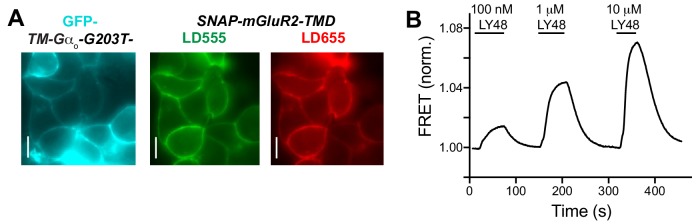
Further analysis of G protein effects on inter-TMD rearrangement.(A) Representative images of HEK 293T cells expression GFP-TM-GαoA-G203T (blue) and SNAP-mGluR2-TMD labeled with donor (green) and acceptor (red). Scale bars = 20 µm. (B) Representative inter-TMD FRET trace showing dose-dependent LY48-induced increases in FRET.